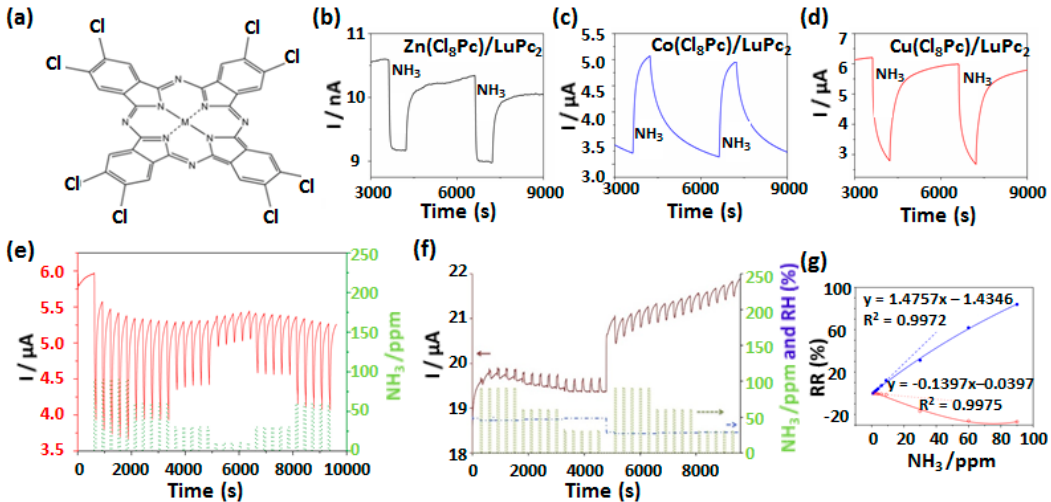
Figure 13. Structure of octachloro-MPc complexes (M: Zn, Co, Cu) (a) and current variations towards alternate exposure to 90 ppm NH 3 and recovery under clean air for Zn(Cl 8 Pc)/LuPc 2 ( b ), Co(Cl 8 Pc)/LuPc 2 ( c ) and Cu(Cl 8 Pc)/LuPc 2 ( d ). Current variations as a function of time for Cu(Cl 8 Pc)/LuPc 2 ( e ) and Cu(F 8 Pc)/LuPc 2 ( f ) devices at different concentrations of NH 3 in a range of 10–90 ppm. The calibration curves depicting RR variation with NH 3 concentration are shown for Cu(Cl 8 Pc)/LuPc 2 and Co(Cl 8 Pc)/LuPc 2 MSDI ( g ) [53,74].